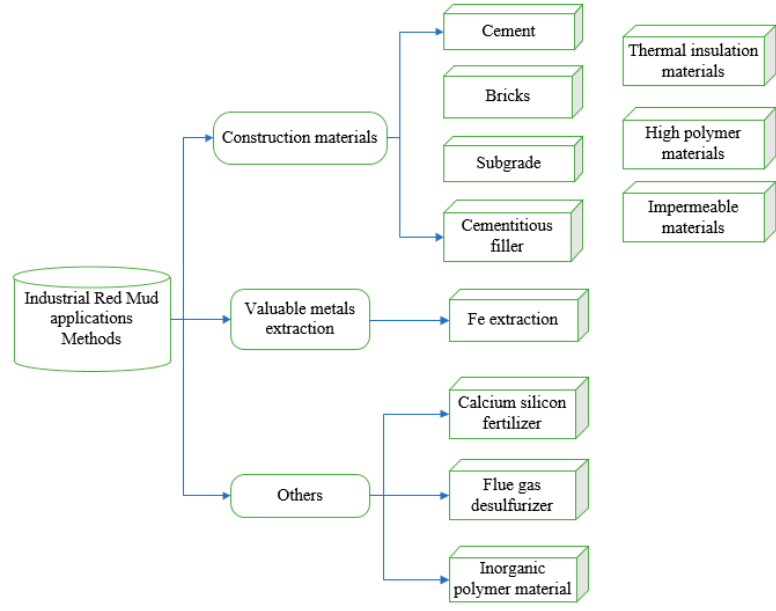
ff erent fields during past 60 years in